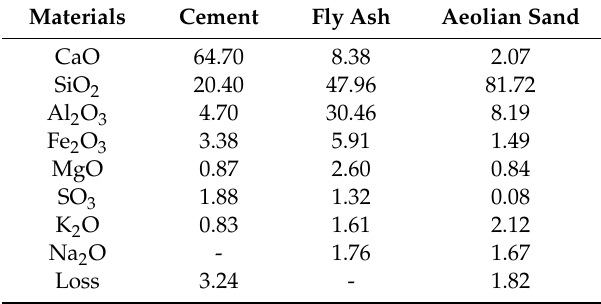
Table 1. Chemical compositions of the cement, fly ash, and aeolian sand